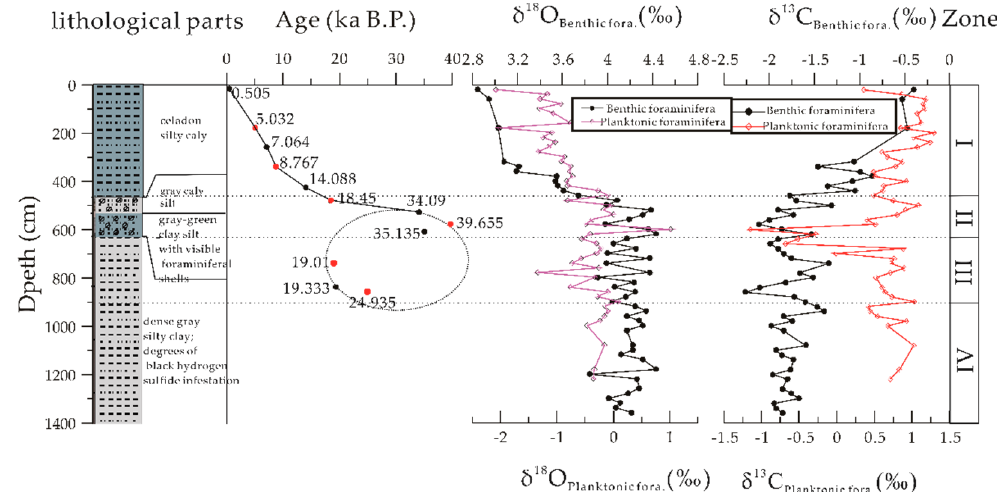
Figure 2. The lithological distribution [46] and AMS 14 C age datum from site 973-4. Red dots represent the data of [42], while black dots represent the data of Lin [47]. Profiles of carbon and oxygen isotopic composition of benthic foraminifera (e.g., Uvigerina spp .) and planktonic foraminifera ( P. obliquiloculata ) at site 973-4 [48].